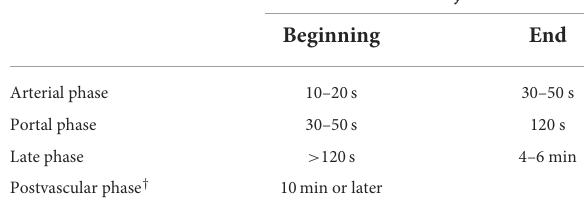
TABLE 1 Phases of contrast